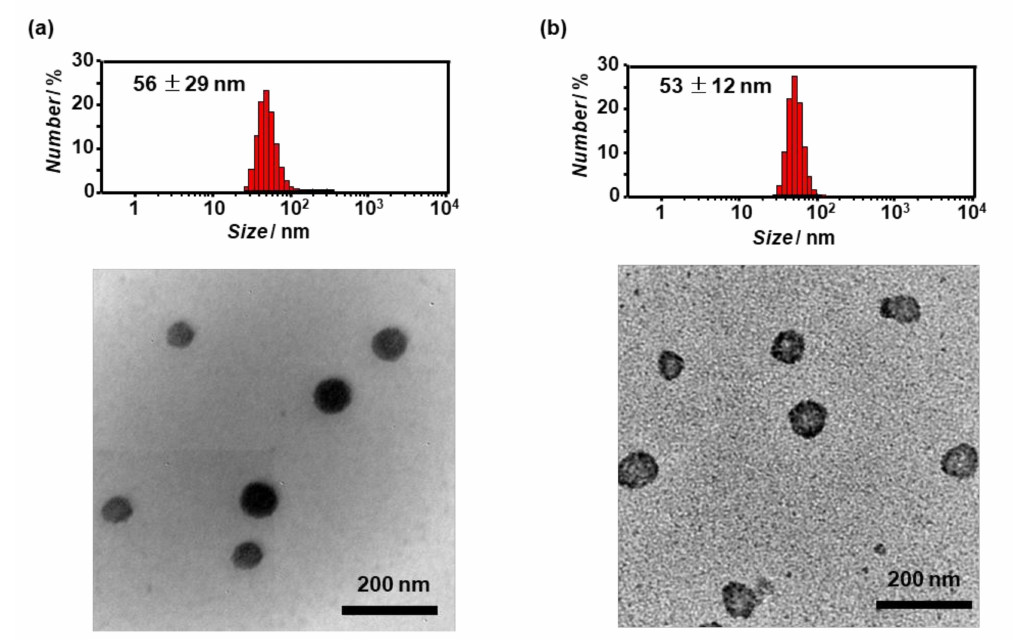
Figure 3. Size distributions obtained from Dynamic Light Scattering (DLS) at 25 ◦ C and transmission electron microscopy (TEM) images for solutions of ( a ) 25 µ M and ( b ) 50 µ M β -annulus peptide modified with Ni-NTA at the C-terminus in a 10 mM Tris-HCl bu ff er (pH